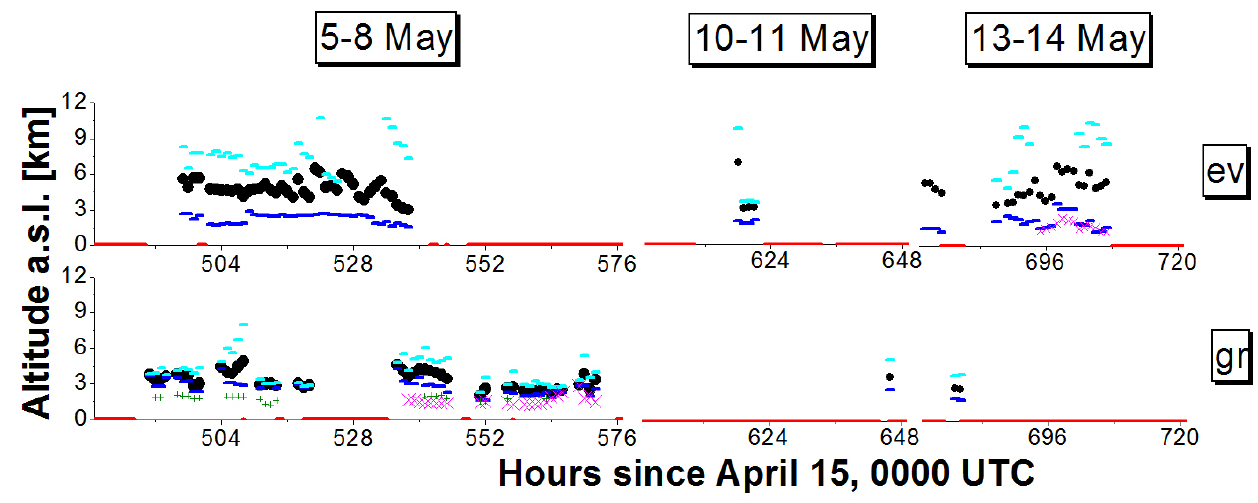
Fig. 7. As Fig. 5 for Western Mediterranean cluster: Evora (ev) and Granada